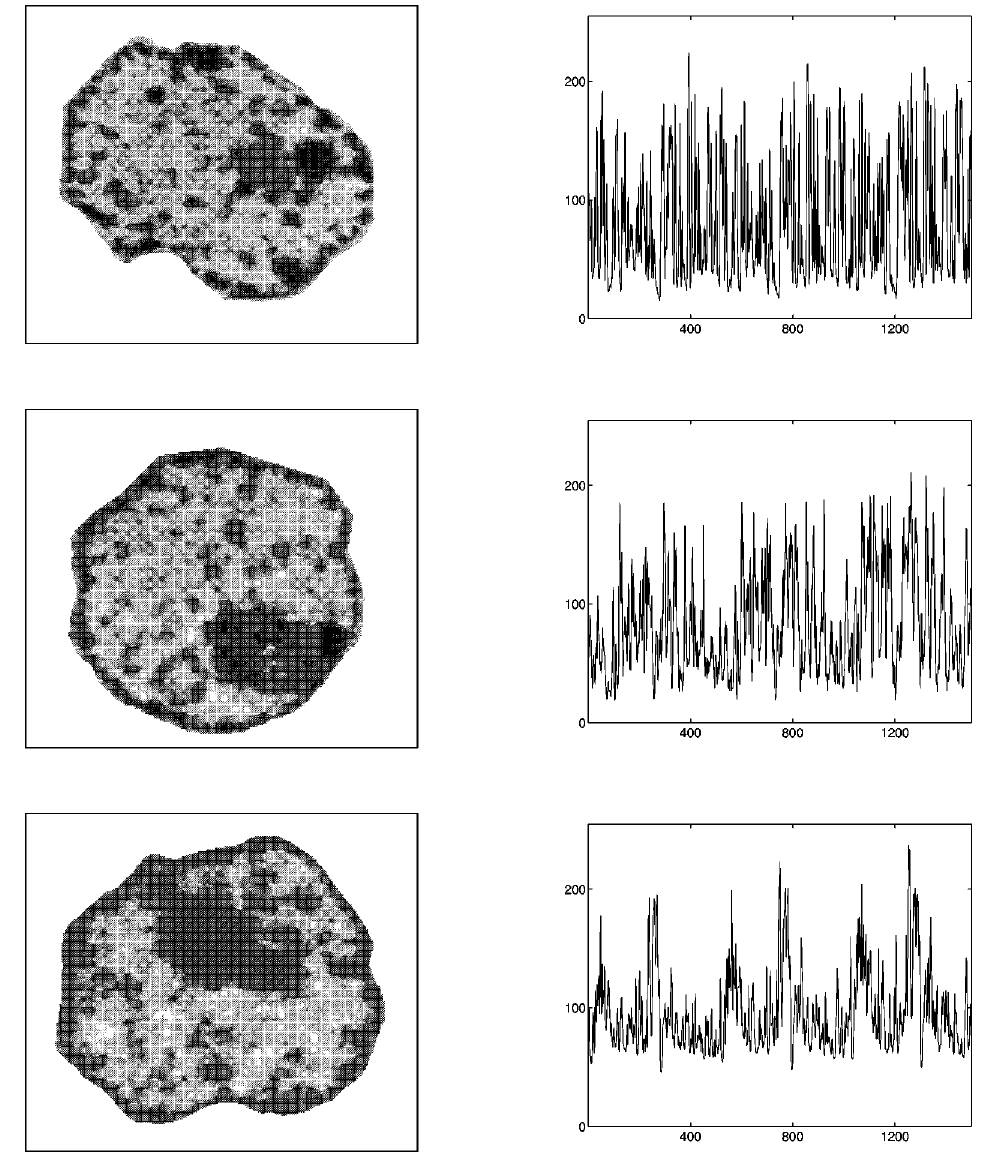
Fig. 2. Cell nuclei chosen from the normal (upper), noduli (middel) and tumour (lower) classes and the corresponding 1D gray level signals of the second peripheral segments. log( S T ) = a + b log( T WD WD